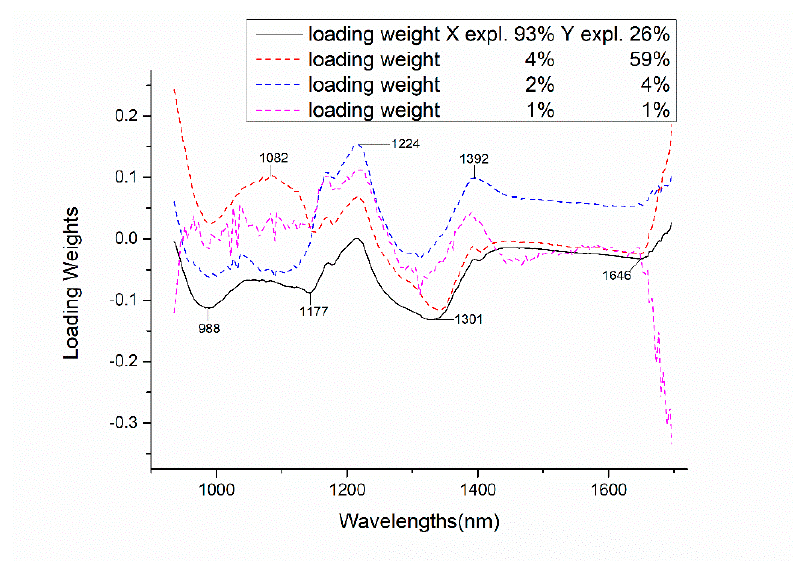
Figure 4. First four loading weights of the best fit partial least squares regression (PLSR) model of no-repartition. The variable X denotes the near-infrared reflectance spectrum; the variable Y denotes the sausage grade. Table 1. Result statistics for Cantonese sausage degree with near infrared spectroscopy (NIR) spectra extracted from samples using the (928–1686 nm) bands from the PLSR models, which include coefficient of determination of the training set (R c2 ), root mean square error of the training set (RMSEC), coefficient of determination of the prediction set (R P2 ), root mean square error of the prediction set (RMSEP), discrimination rate of the training set (D c ), discrimination rate of the prediction set (D P ).